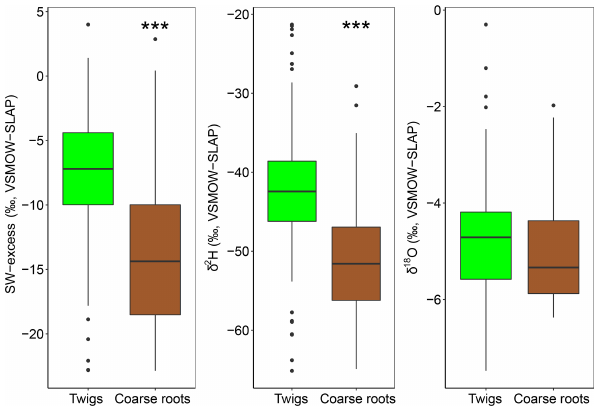
Figure 4. SW-excess, δ 2 H and δ 18 O of xylem samples of dominant F. sylvatica and Q. robur depending on the part of the tree sample (twigs or coarse roots). Significant differences between twigs and coarse roots ( P < 0 . 001) are highlighted with asterisks (***). Box size represents the interquartile range, the black line is the median, the whiskers indicate variability outside the upper and lower quar- tiles, and individual points are outliers. Xylem samples from the first sampling campaign were excluded from the analysis because of probable winter branch evaporation (see text).